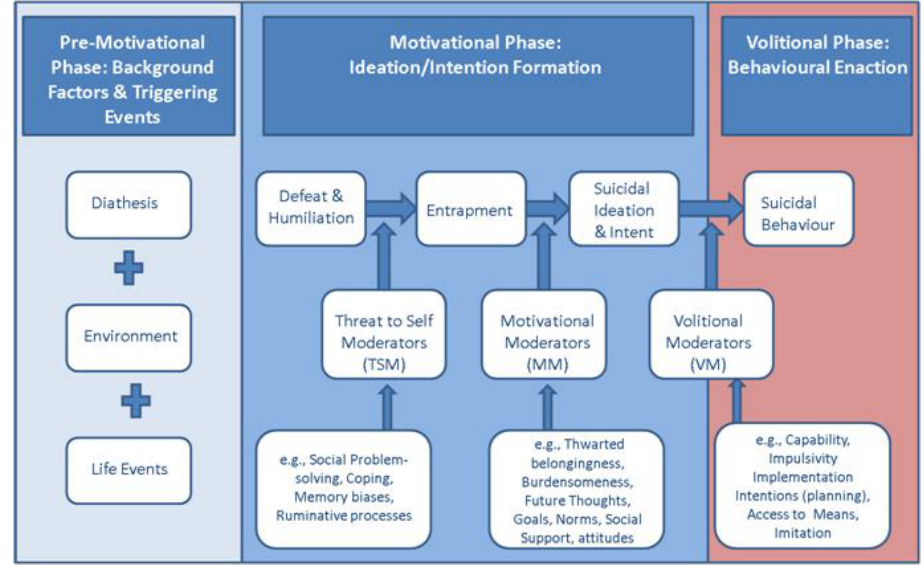
Figure 1. The Integrated Motivational Volitional (IMV) model of suicidal behaviour.